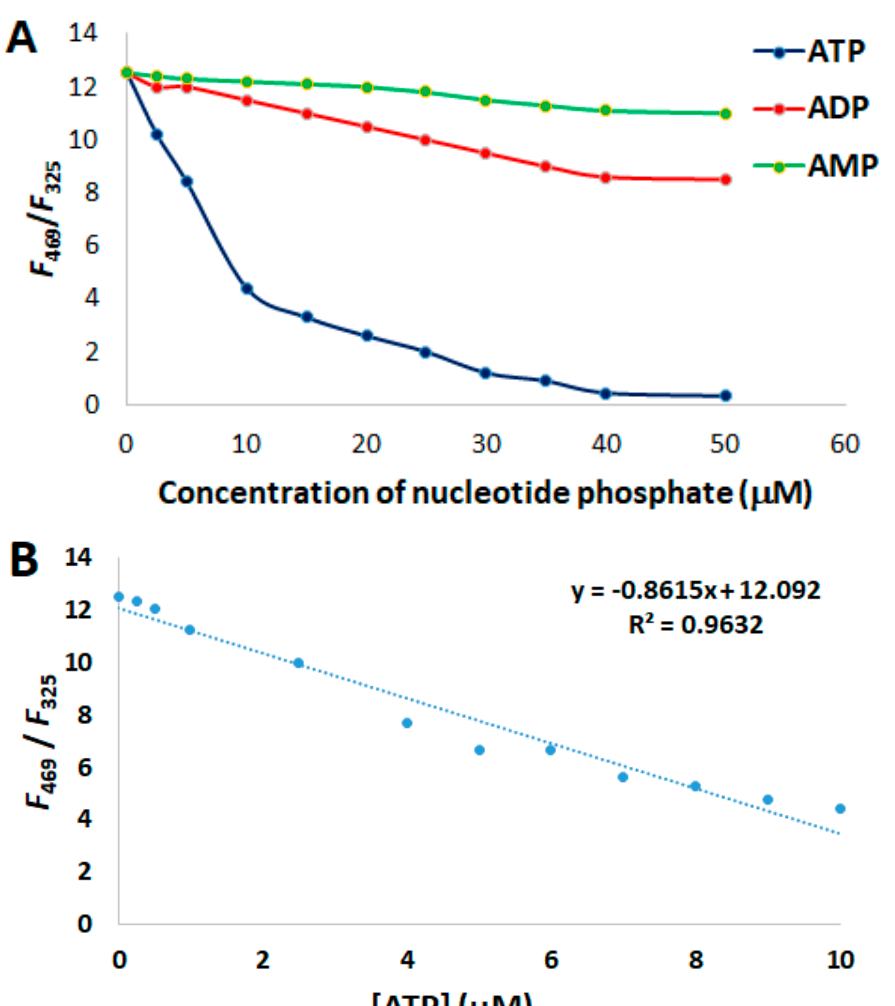
Figure 4. ( A ) Dependence of emission ratio of the probe 5 ( R = F 469 / F 325 ) on the nucleotide concentration. ( B ) Linear relationship between emission response of the probe and ATP concentration. [5] = 10 µ M; excitation wavelength = 300 nm.